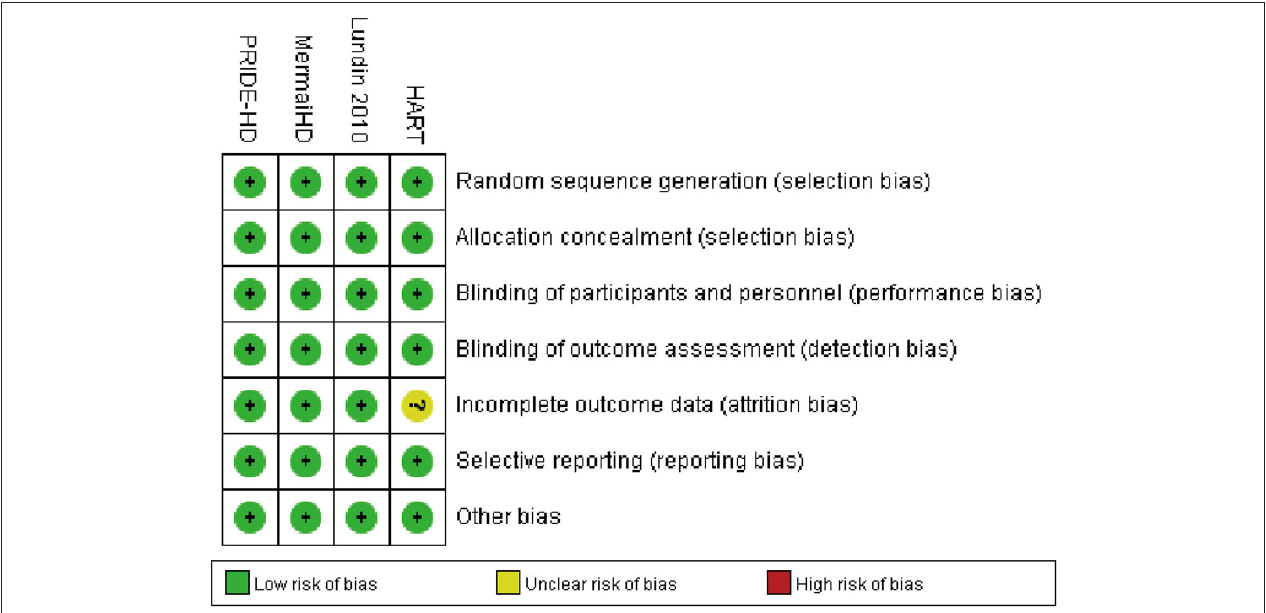
FIGURE 5 | Risk of bias: A summary table for each risk of bias item for each study.